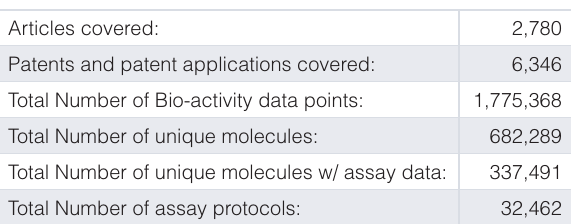
Table 1. Eidogen-Sertanty Kinase Knowledgebase. Summary Statistics – Q1 2016 Release. Articles